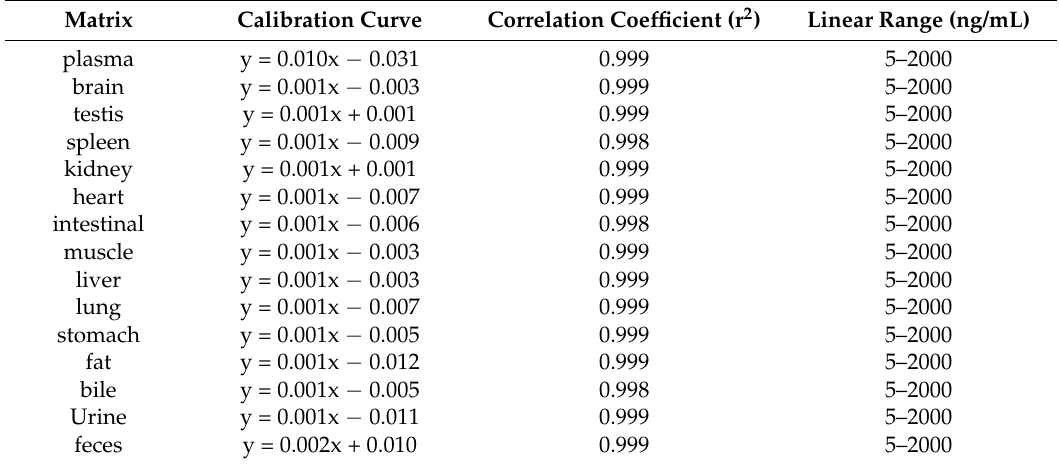
Table 2. Linearity and Linear range of ZGS1 calibration curves in different biological matrix.